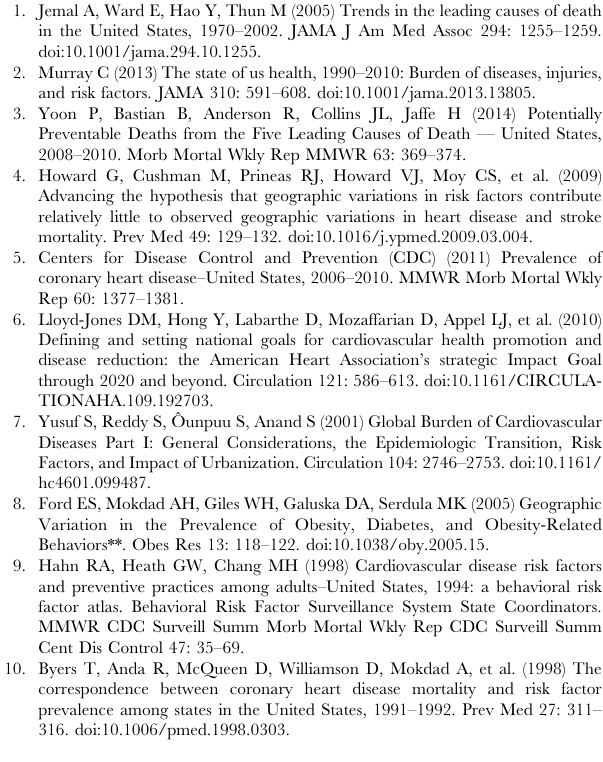
Figure S1 The relation between the CV risk index and state- level cause-specific mortality rates in 2010 for men (top panel) and women (bottom panel) aged 45–74 y. Washington DC had relatively high CV mortality rates for its value of the CV risk index and appears to be an outlier; removing Washington DC from the analysis did not affect the